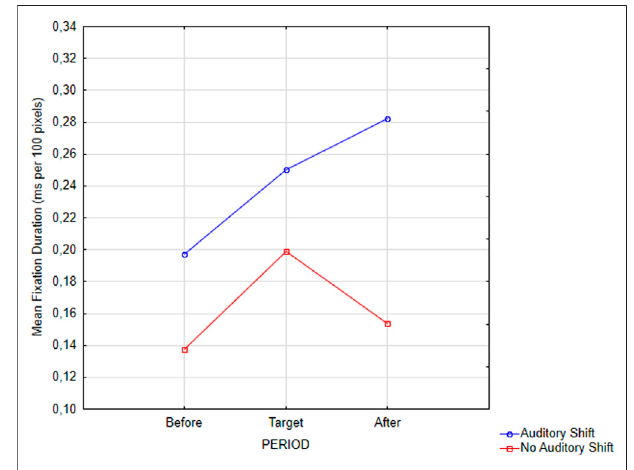
FIGURE 4 | Non-Signi fi cant interaction between period (Before, Target, After) and AUDITORY perspective shift (Visual Shift, No Visual Shift).